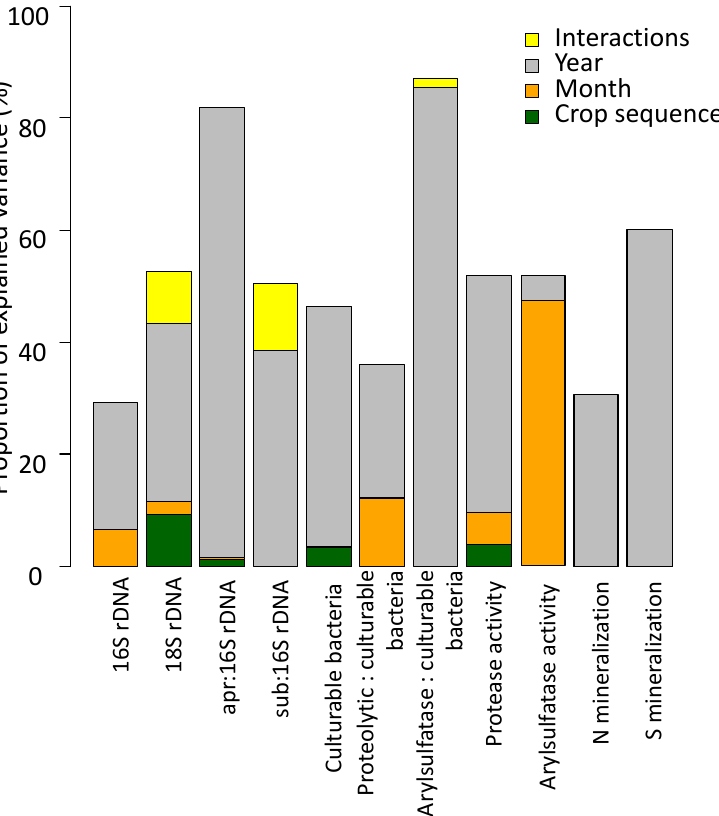
Figure 3. Percentage of explained variance by crop sequence, year, month and their interactions on microbial abundances and activities.